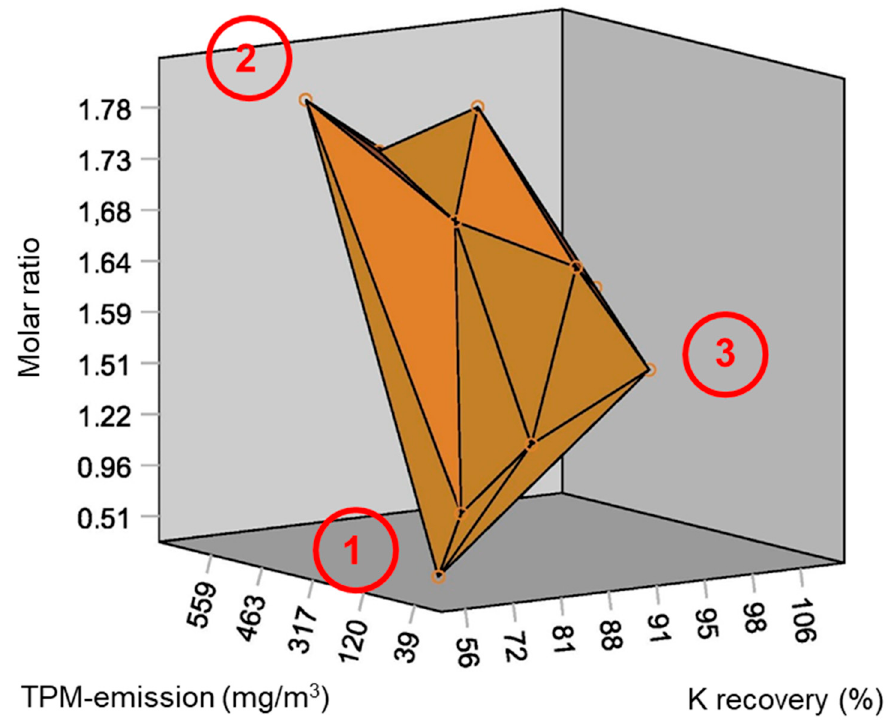
Figure 9. Comparison of TPM-emissions in mg/m 3 , K recovery rate in GA in %, and molar K/(Cl + 2S + Al) ratio in biomass.